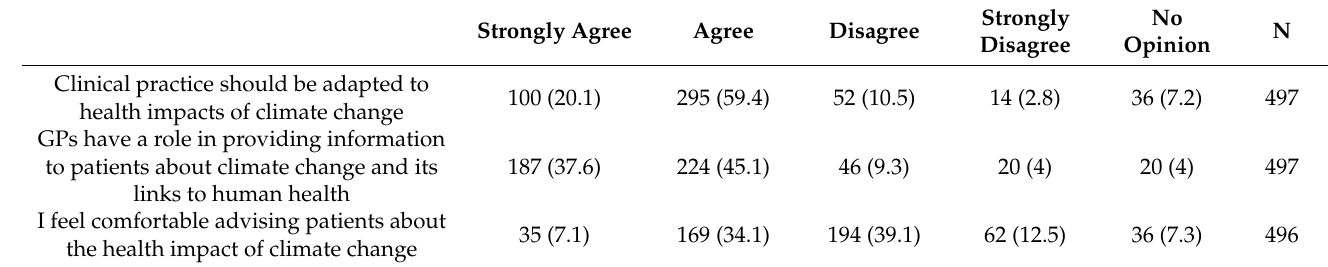
Table 2. GPs’ opinion on adapting the clinical setting to health impact of climate change and providing information about the issue to patients, N (%).